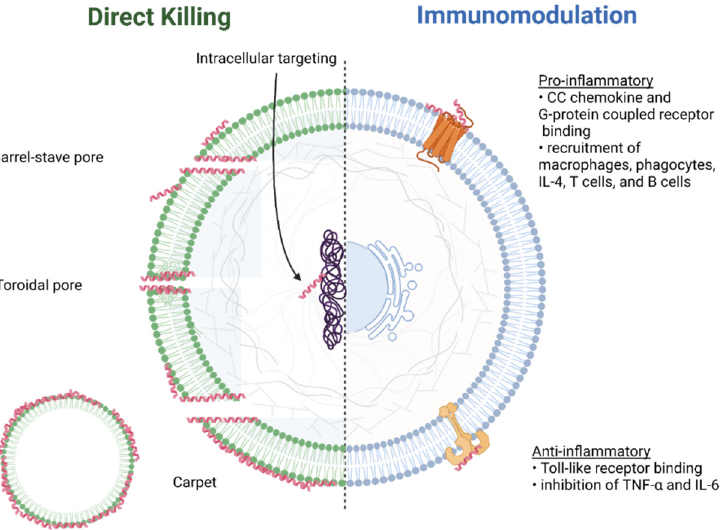
Figure 5. Overview of roles and observed mechanisms of action of antimicrobial peptides (created with BioRender.com, accessed on 1 August 2022). Either direct killing of bacteria and fungi, immunomodulation of host cells or a combination of both mechanisms are observed with AMPs.